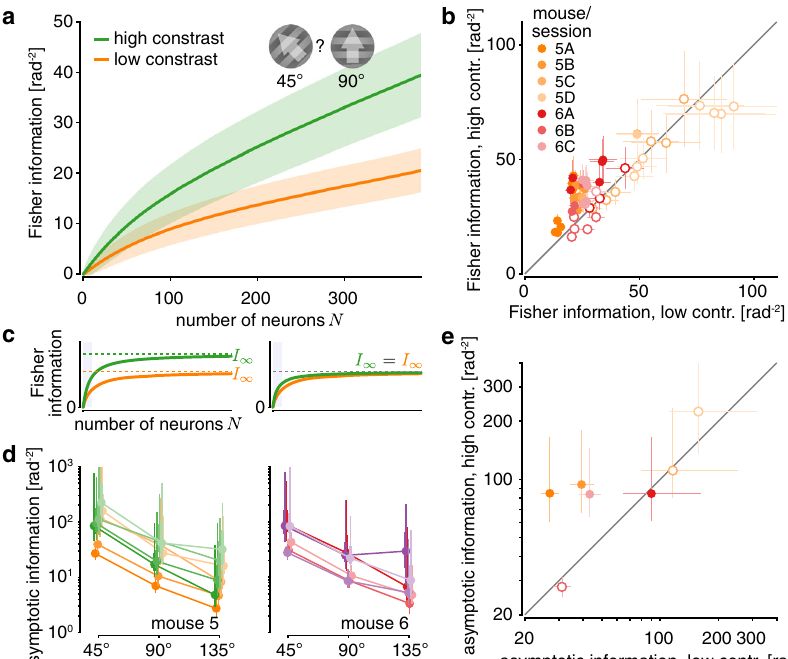
Fig. 6 Increasing stimulus contrast boosts asymptotic information in V1. a The information increases more rapidly with population size for high-contrast stimuli (green; mean ± 1 SD) than for low-contrast stimuli (orange; mean ± 1 SD), here shown for the discrimination between 45 ° vs. 90 ° drift direction trials of one session of mouse 5. An increase in stimulus contrast signi fi cantly increases the total information in the recorded population (bootstrap, two- sided p < 10 − 5 ). b The information in the recorded population was larger for high than low stimulus contrast for most δθ = 45 ° discriminations across mice and sessions (colors, XY = mouse X, session Y). Each dot shows the information for one discrimination between different drift directions (8 dots per session; error bars = ± 1 SD of the information estimation uncertainty). Filled dots indicate a signi fi cant information increase (bootstrap, two-sided p ≥ 0.05). c Observing an information increase in the recorded population (blue shaded area) does not necessarily imply an increase in asymptotic information (left vs. right). d The estimated asymptotic information was generally higher for high-contrast stimuli (green/magenta; shades = sessions) than low- contrast stimuli (orange/red; shades = session; colors as in panel b ), across different drift direction differences δθ (pooled estimates across different drift direction pairs; posterior density summaries as in Fig. 4c). e To compare the pooled asymptotic information estimates for δθ = 45 ° for low-contrast trials to those for high-contrast trials, we plot them against each other (one dot per session, colors as in panel b , error bar centers = posterior medians, error bars = 50% posterior credible intervals). The four fi lled dots indicate sessions for which the information in the recorded population (panel b ) is signi fi cantly larger for higher contrast stimuli for the majority of